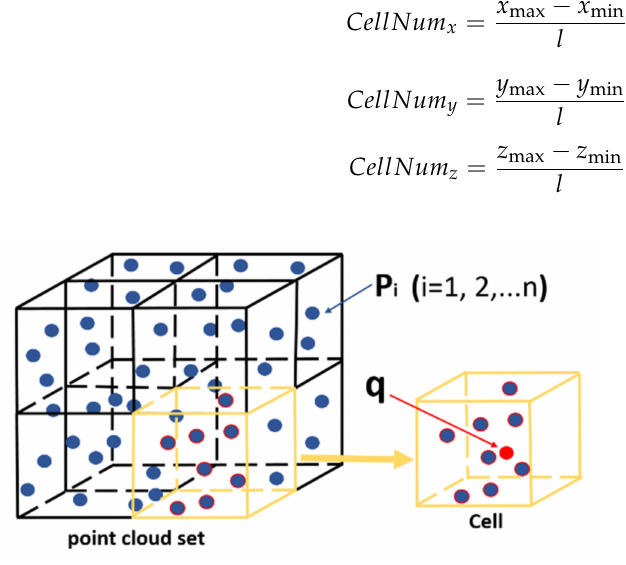
Figure 6. Schematic diagram of grid-based data